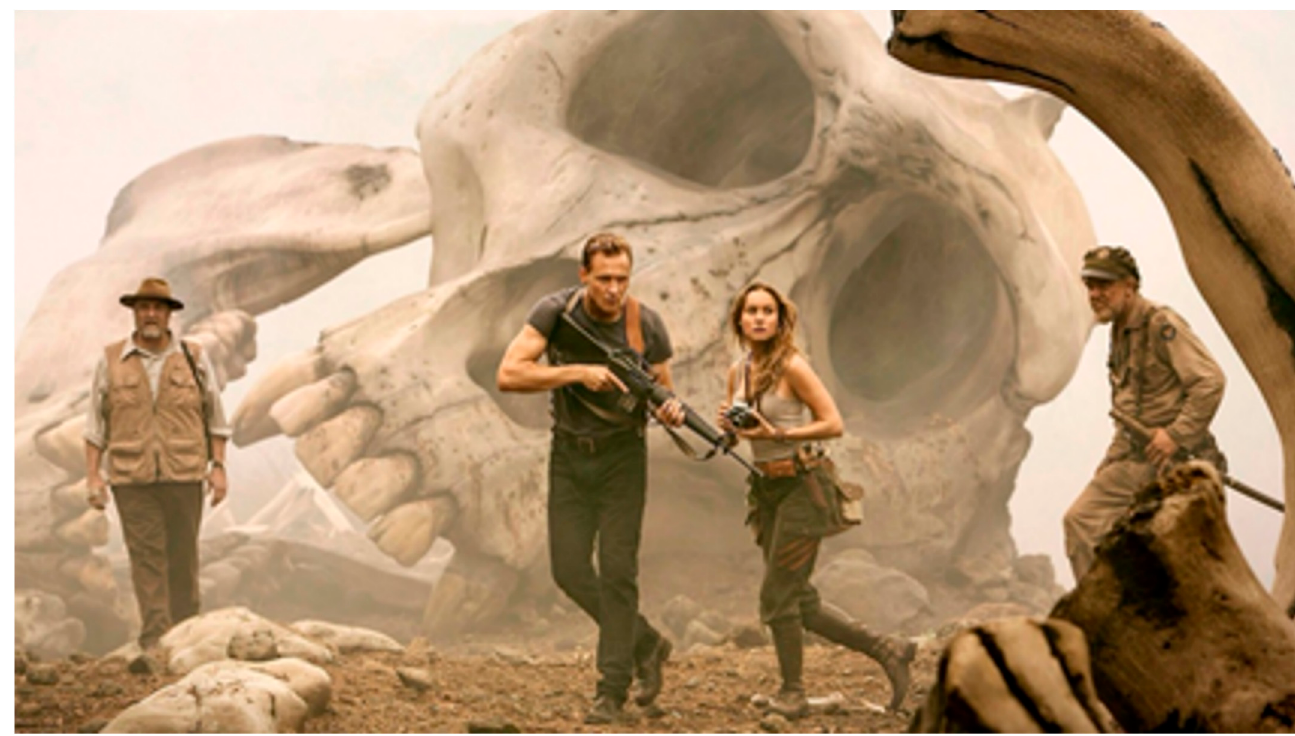
Figure 12. A giant skull in Kong’s parents’ cemetery (2017). https://www.intofilm.org/news-and-views/articles/kong- skull-island-feature (accessed on 1 January 2021).